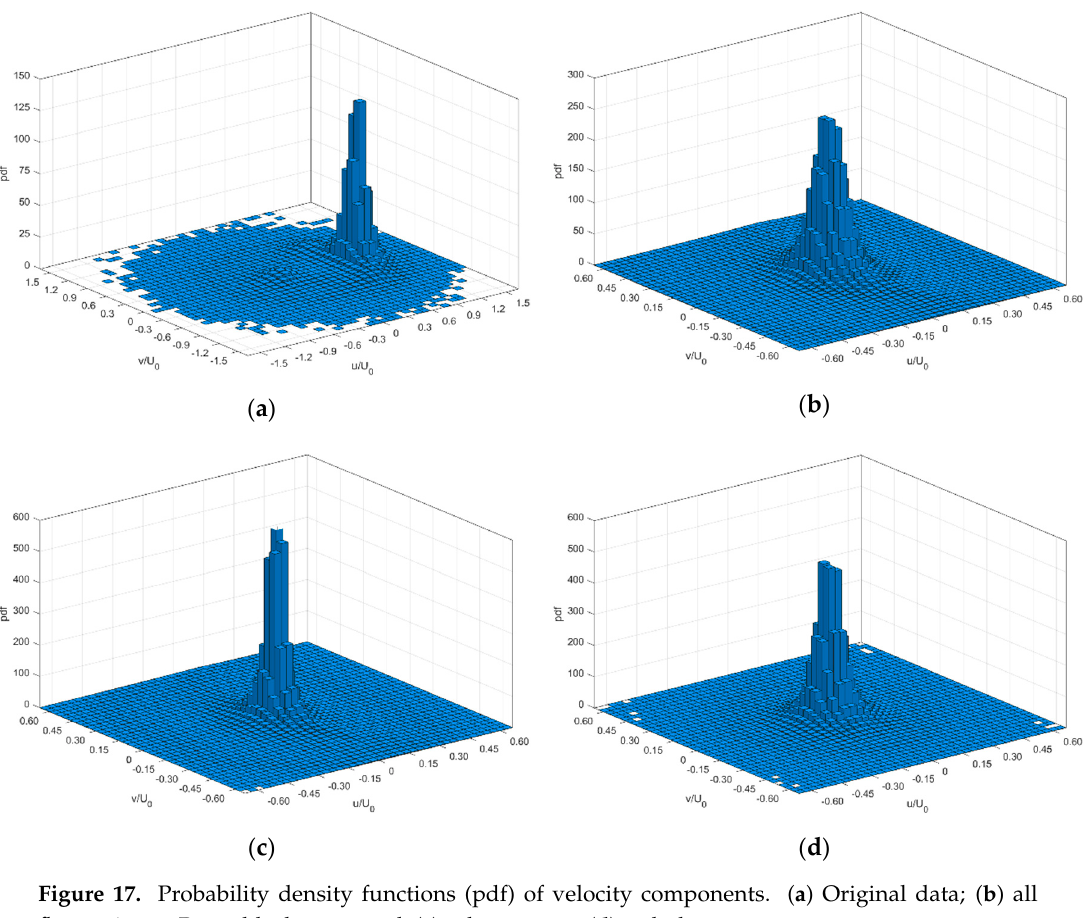
Figure 17. Probability density functions (pdf) of velocity components. ( a ) Original data; ( b ) all fluctuations—Reynolds decomposed; ( c ) coherent part; ( d ) turbulent part.